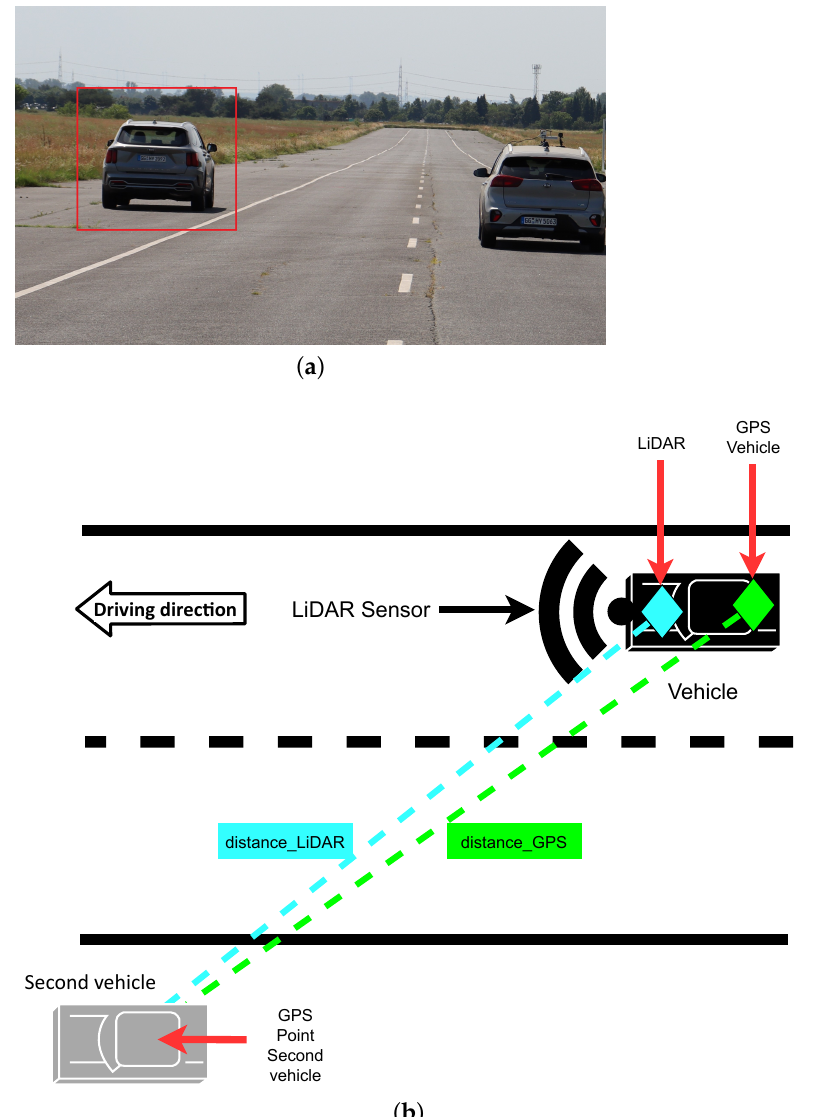
Figure 4. Scenario 4 ( a ) A second still-standing vehicle is the detection target. ( b ) Top view of the Scenario 4.